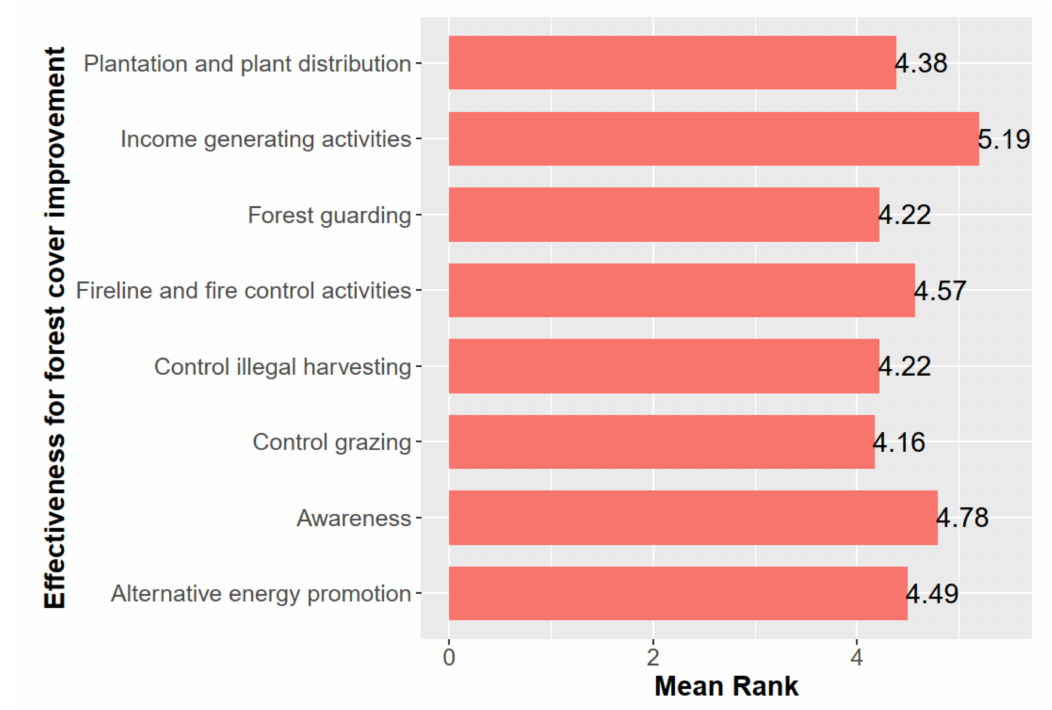
Figure 9. Perceived e ff ectiveness of community forestry activities for forest cover